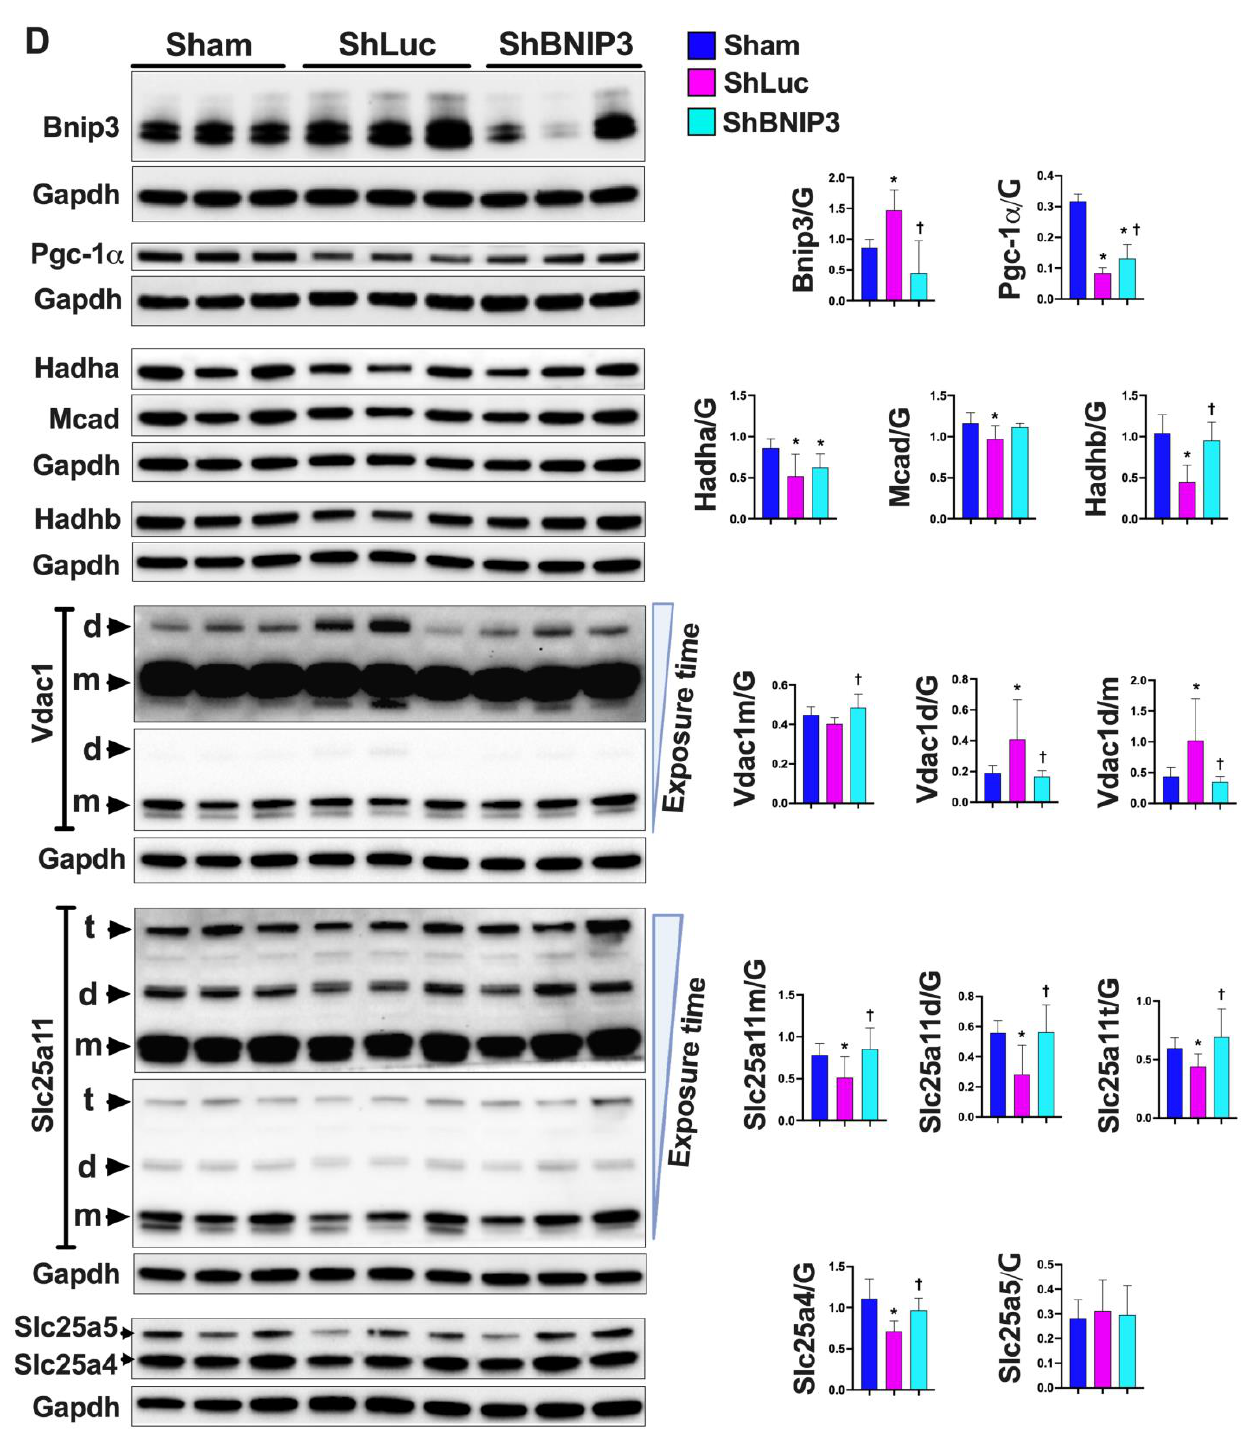
Figure 2 . Validation of the LV and RV proteomic findings. ( A ). “ Core Analyses ” was performed in IPA for each of the two-group comparisons, i.e., ShLuc vs. Sham and ShBNIP3 vs. ShLuc, with a cutoff p - value < 0.05. Analyzed datasets were then compared with each other in IPA’s “ Comparison Analyses ” function to yield the most enriched Canonical Metabolic Pathways (left) and Upstream Regulators (right) that were shared among the two-group comparisons. The respective z-score-based heat maps indicate shared Canonical Pathways and Upstream Regulators that were upregulated/activated or downregulated/inhibited in the two-group comparisons, with orange and blue color intensities representing the z-score-based extent of upregulation/activation or down-